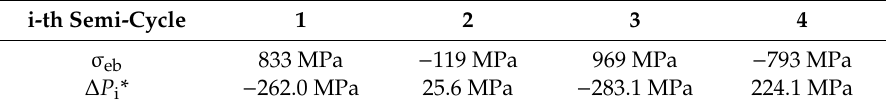
Table 2. Equibiaxial stress and corresponding change of forces ∆ P i *.